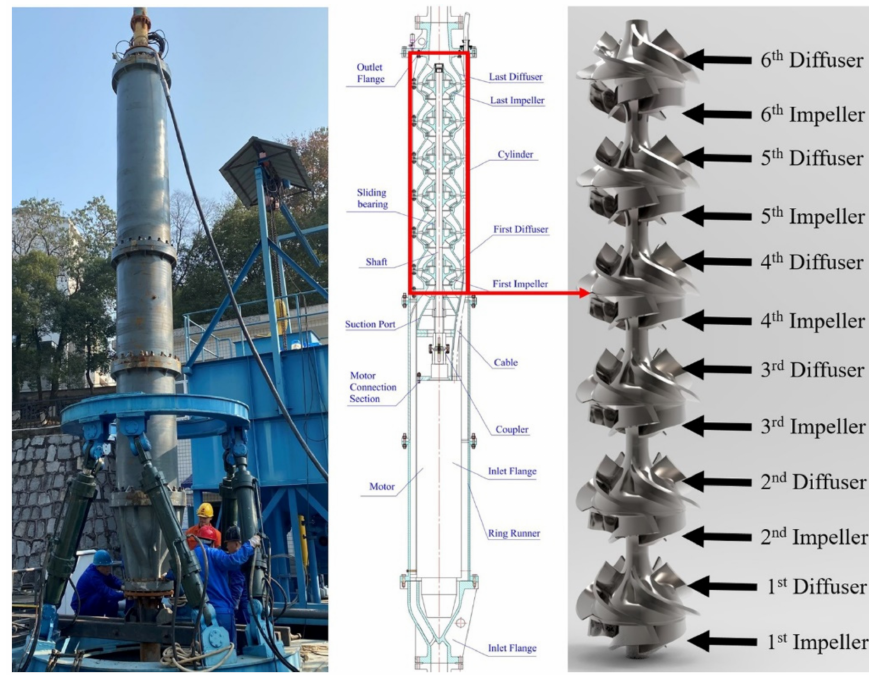
Figure 1. Overall structural design of the six-stage centrifugal